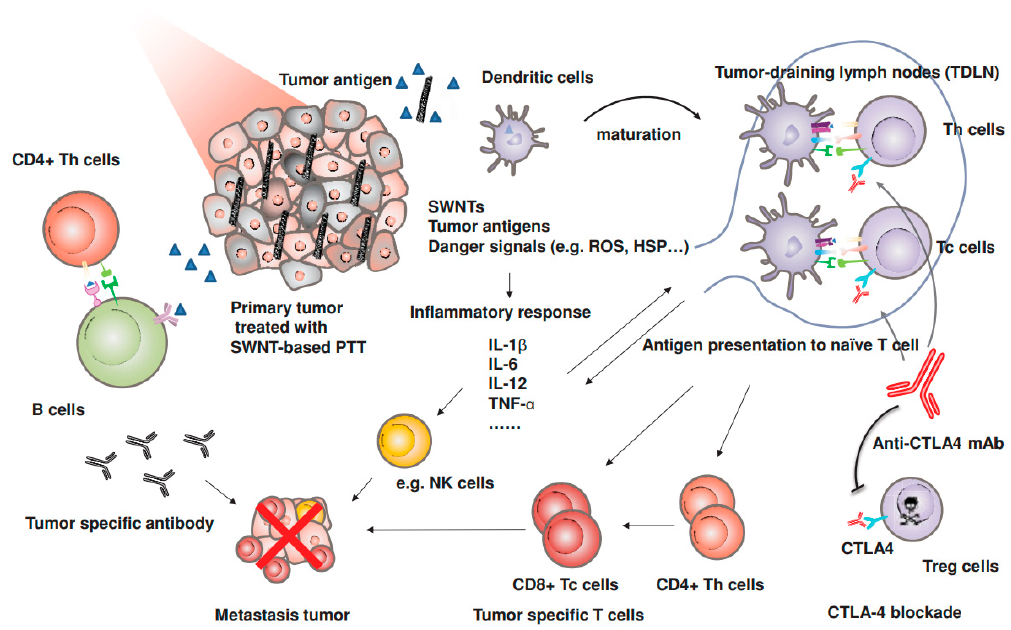
Figure 4. Proposed mechanism of nanomaterial-enhanced photoimmunological therapy. Tumors treated with SWCNT PTT can instigate a systemic immune response to treat metastatic cancers that can be potentiated through anti-CTLA-4 checkpoint inhibitor therapy. Reproduced with permission from [57]. Copyright © 2014 John Wiley and Sons.